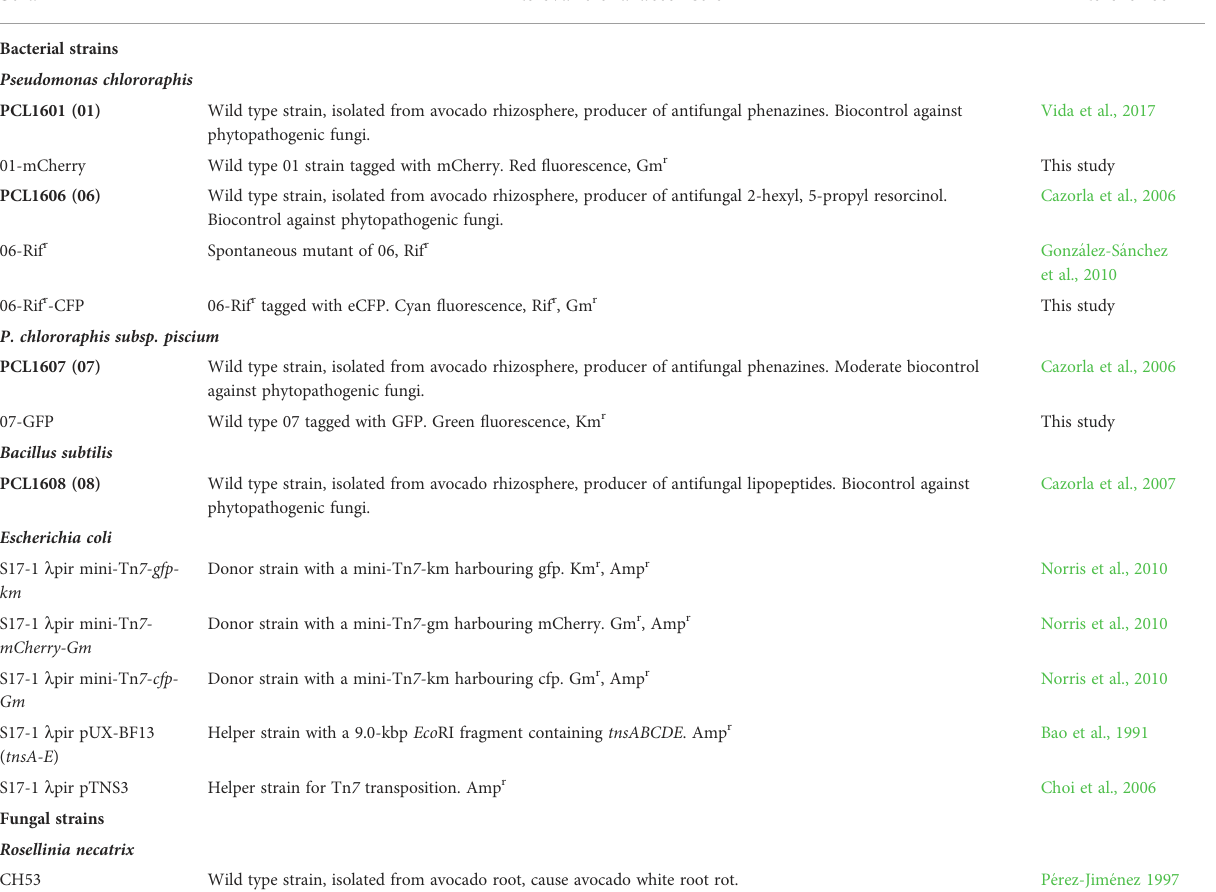
TABLE 1 Microbial strains and plasmid used in this